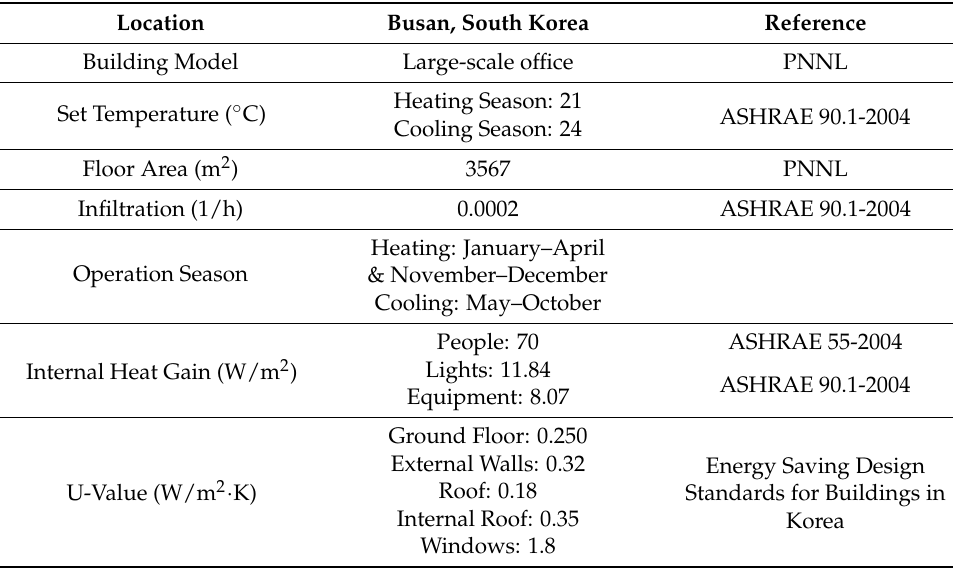
Figure 4. Large-scale office building model. Table 2. Specifications of building load model.